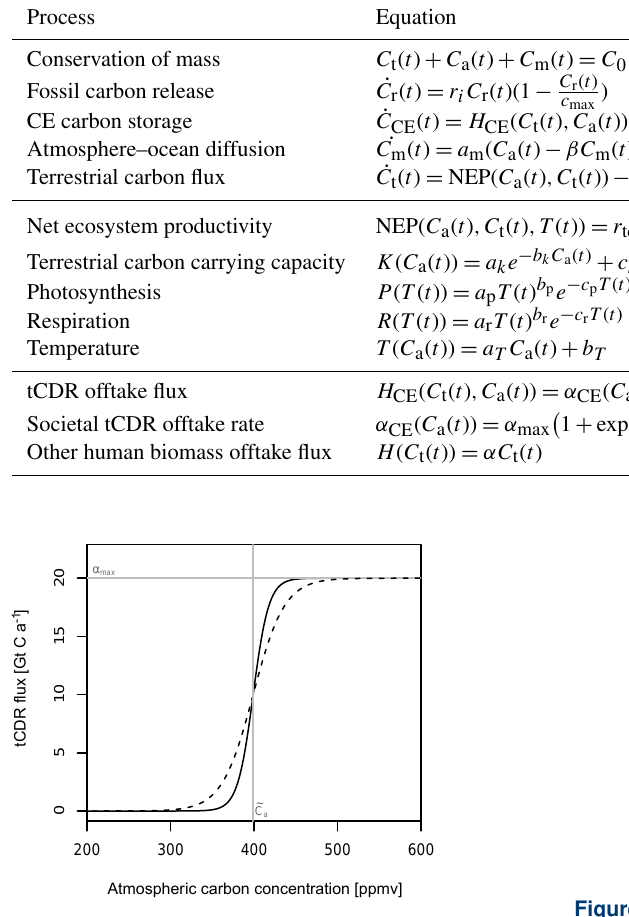
Figure 2. Sigmoidal dependence of the tCDR flux on atmospheric carbon concentrations for two values of the tCDR implementa- tion capacity parameter (slope): s CE = 0 . 1ppmv − 1 (solid line) and s CE = 0 . 05ppmv − 1 (dashed line). The threshold parameter ( f C a ) is set at 400ppmv atmospheric carbon concentration and the potentially achievable tCDR flux is parameterised with α max = 20GtCa − 1 .